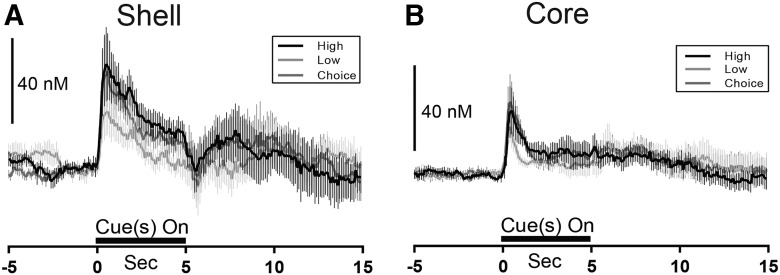
Dopamine release dynamics in the NAc shell and core during the magnitude based decision-making task. A, Average dopamine release in the shell across all rats and trial types. B, Average dopamine release in the core across all rats and trial types. Dashed line at time 0 indicates cue period in A and B.